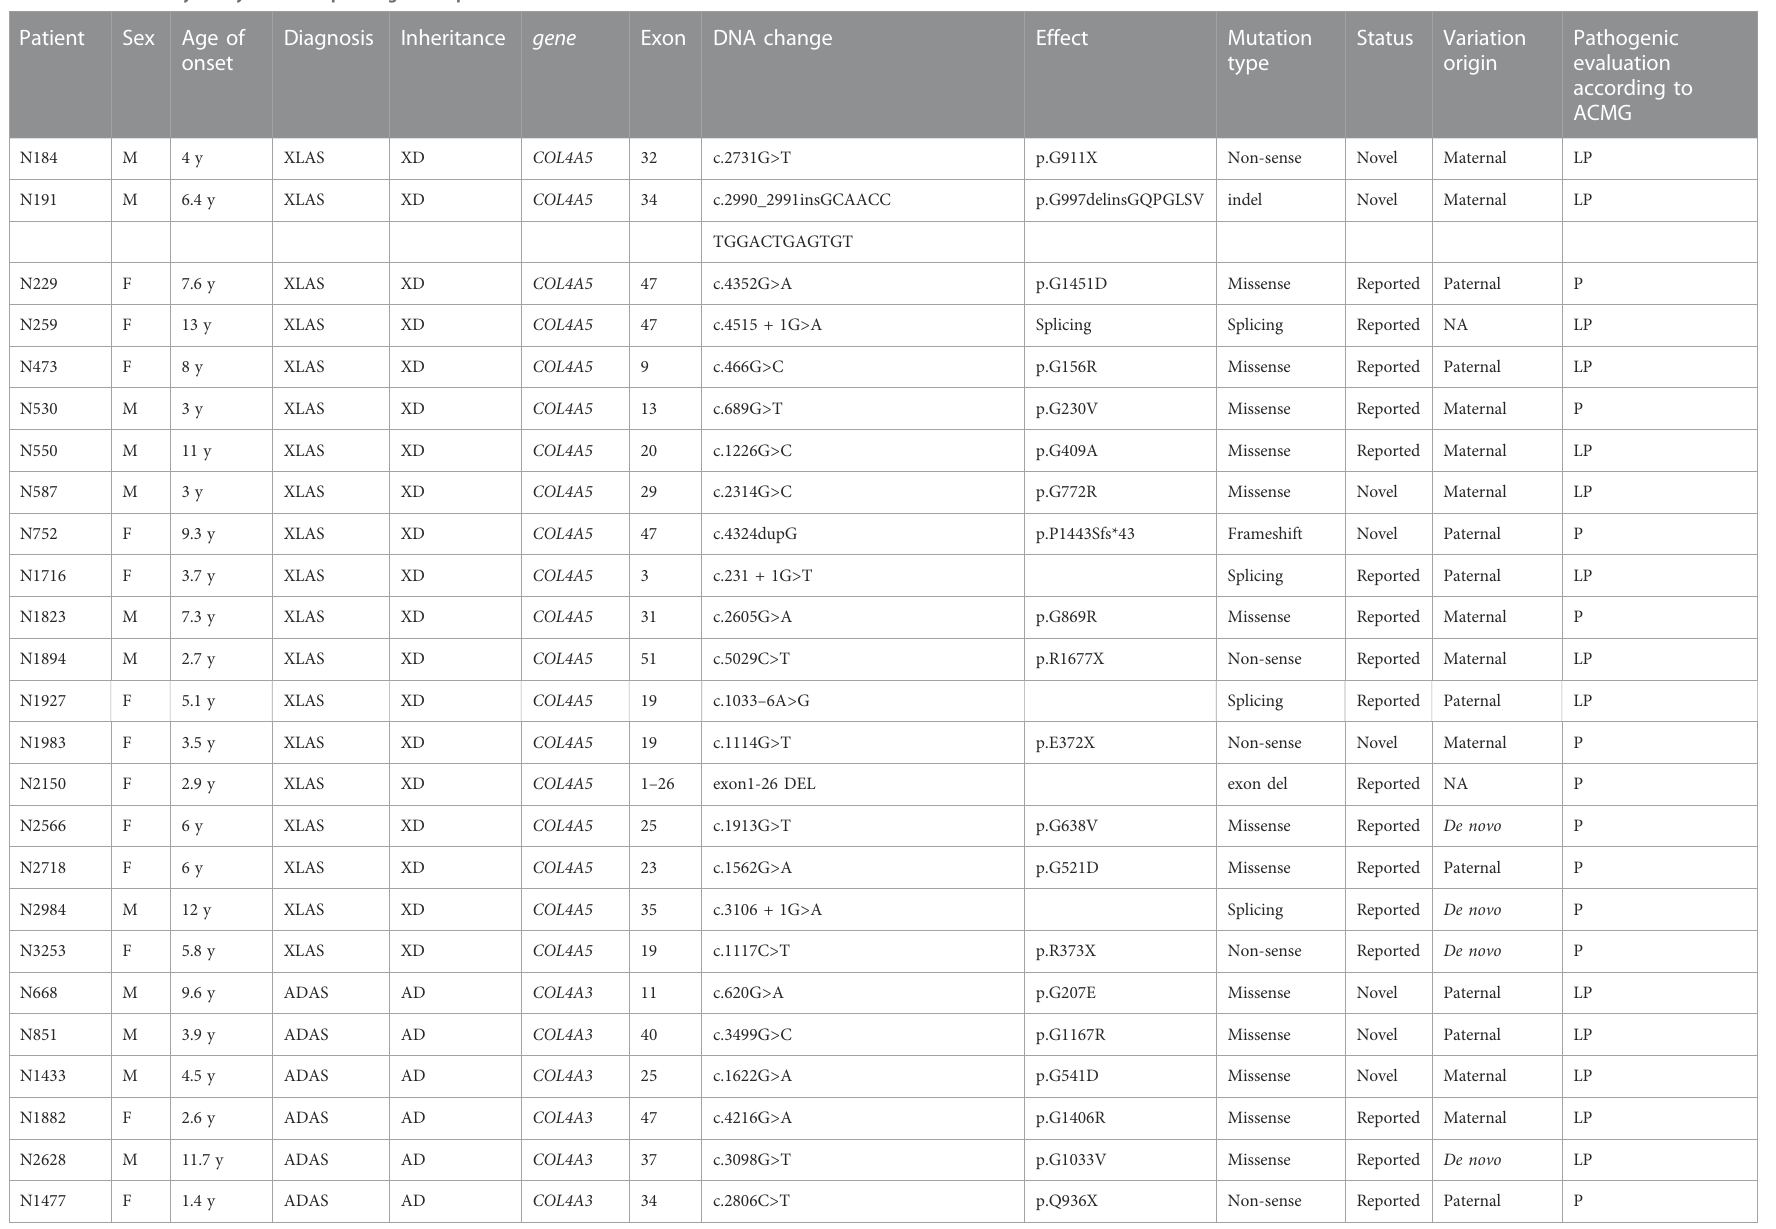
TABLE 2 Variants analyzed by exome sequencing in the patients from 55 Chinese